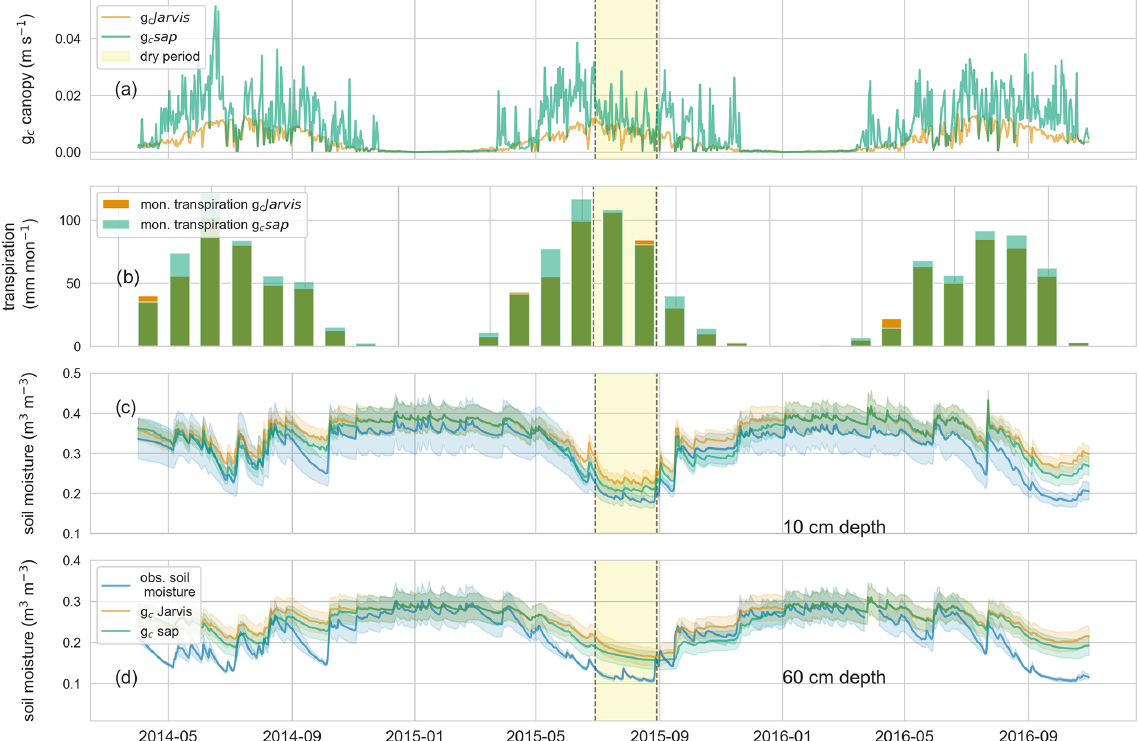
Figure 3. (a) Daily averaged canopy conductance estimates for g c sap (green) and g c Jarvis (orange); (b) monthly transpiration sums estimated using g c sap (green) and g c Jarvis (orange); observed (blue) and simulated soil moisture ± standard deviation of the corresponding simulation and observations ( g c sap: green; g c Jarvis: orange) at 10 (c) and 60cm depth (d) . Highlighted in yellow is a dry period from July to August